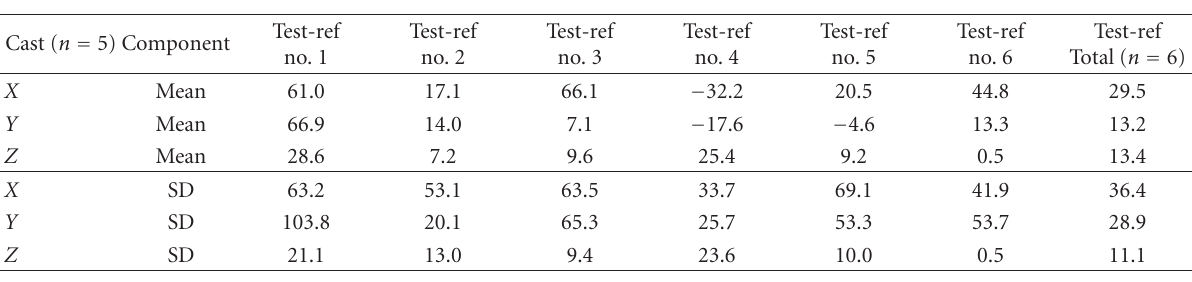
Table 6: The mean and SD of the centroid location di ff erences in µ m of each component between test framework and reference cast generated by the unfixed coordinate system best-fit matching method. The right most column presents their total mean and SD ( n = 6).